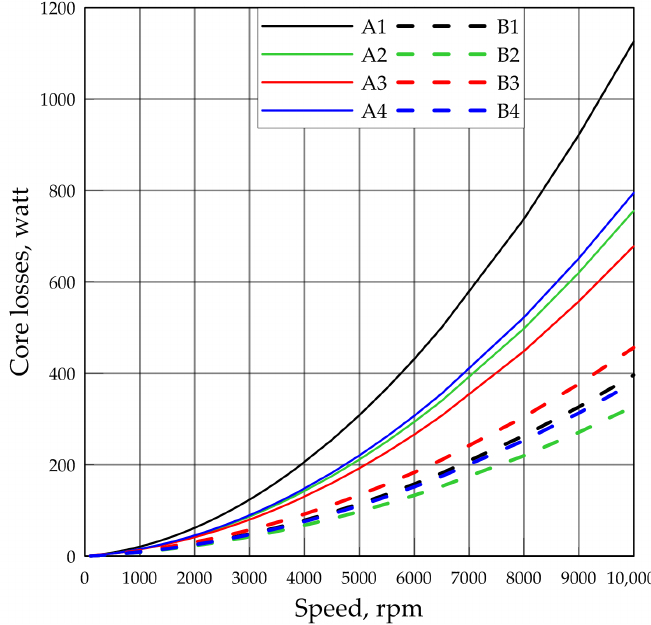
Figure 11. Core losses of selected optimal designs over wide range of